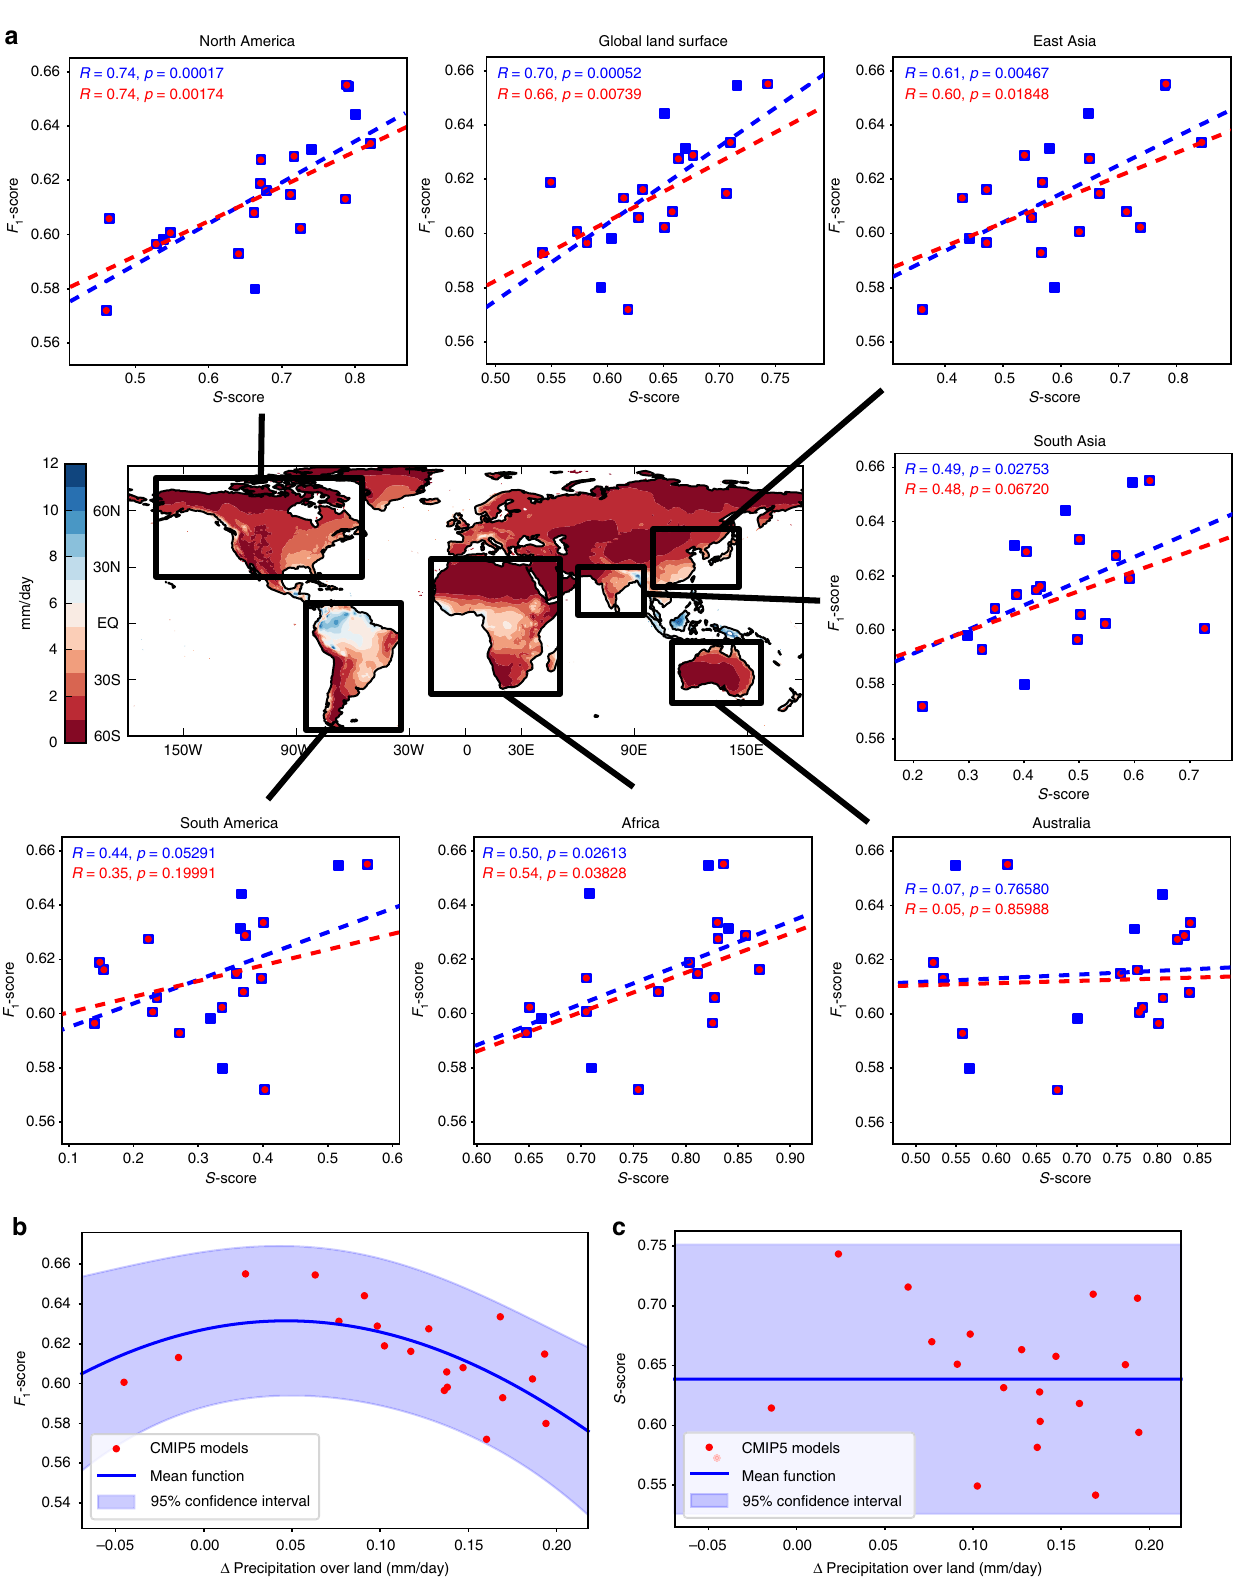
driver of network connectivity (see Methods for a comparison of our network methodologies). Having highlighted the importance of storm tracks, we also point out that the simpler pattern correlation storm track